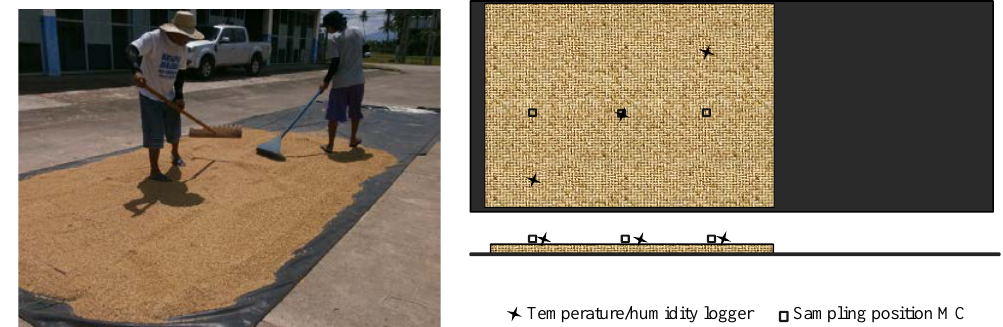
Figure 5. Manual mixing during the drying and position of measuring devices, top view and cross-section view, at IRRI in Los Baños, Republic of the Philippines (14°9 ′ 55 ′′ N, 121°15 ′ 37 ′′ E).